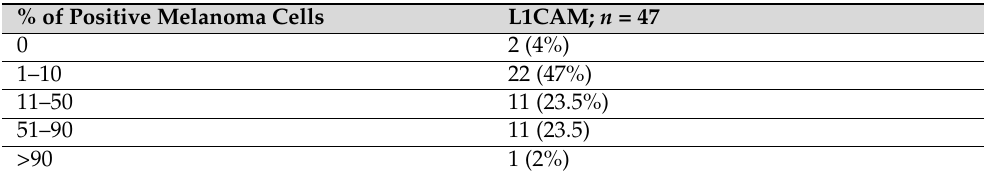
Table 3. L1CAM expression in primary